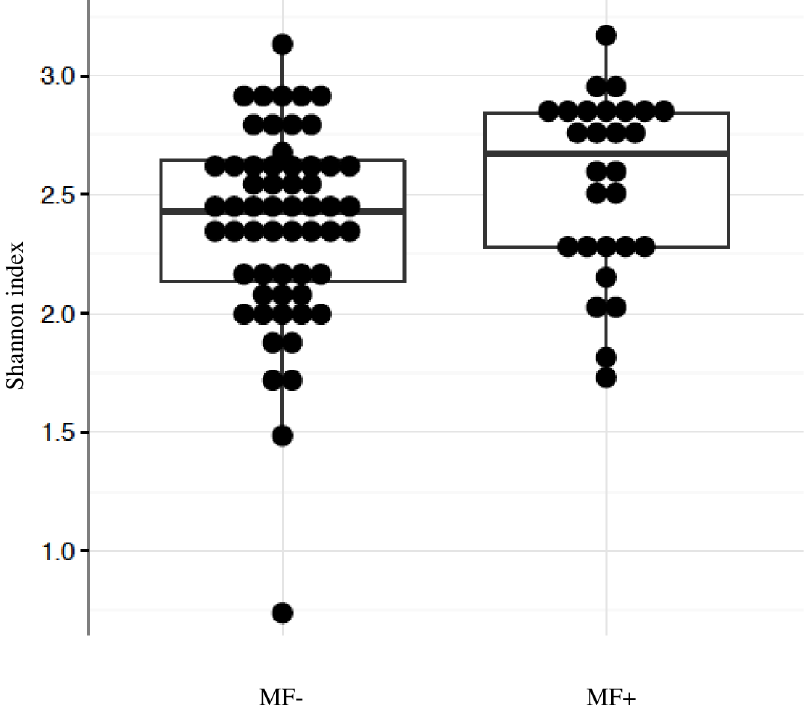
Fig 1. Shannon index of alpha diversity. Pairwise Mann-Whitney test was used to compare alpha diversity estimates, MF- vs. MF+ (p = 0.05). MF- group includes DM- plus DM+/MF- (n = 69), MF+ group includes DM+/MF+ (n = 30). Abbreviations: DM = type 2 diabetes mellitus, MF =